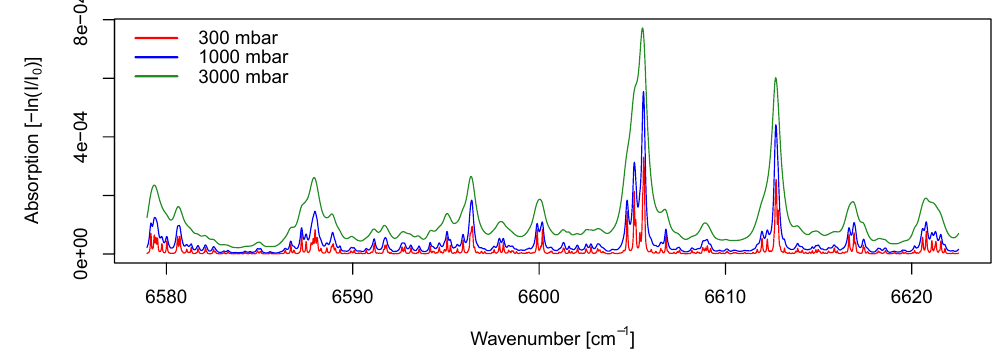
Figure 5. Simulation of optical absorption by 20 ppm v of ammonia at 1.51 µ m band under three pressure levels at 25 °C with a 40-cm transmission distance.